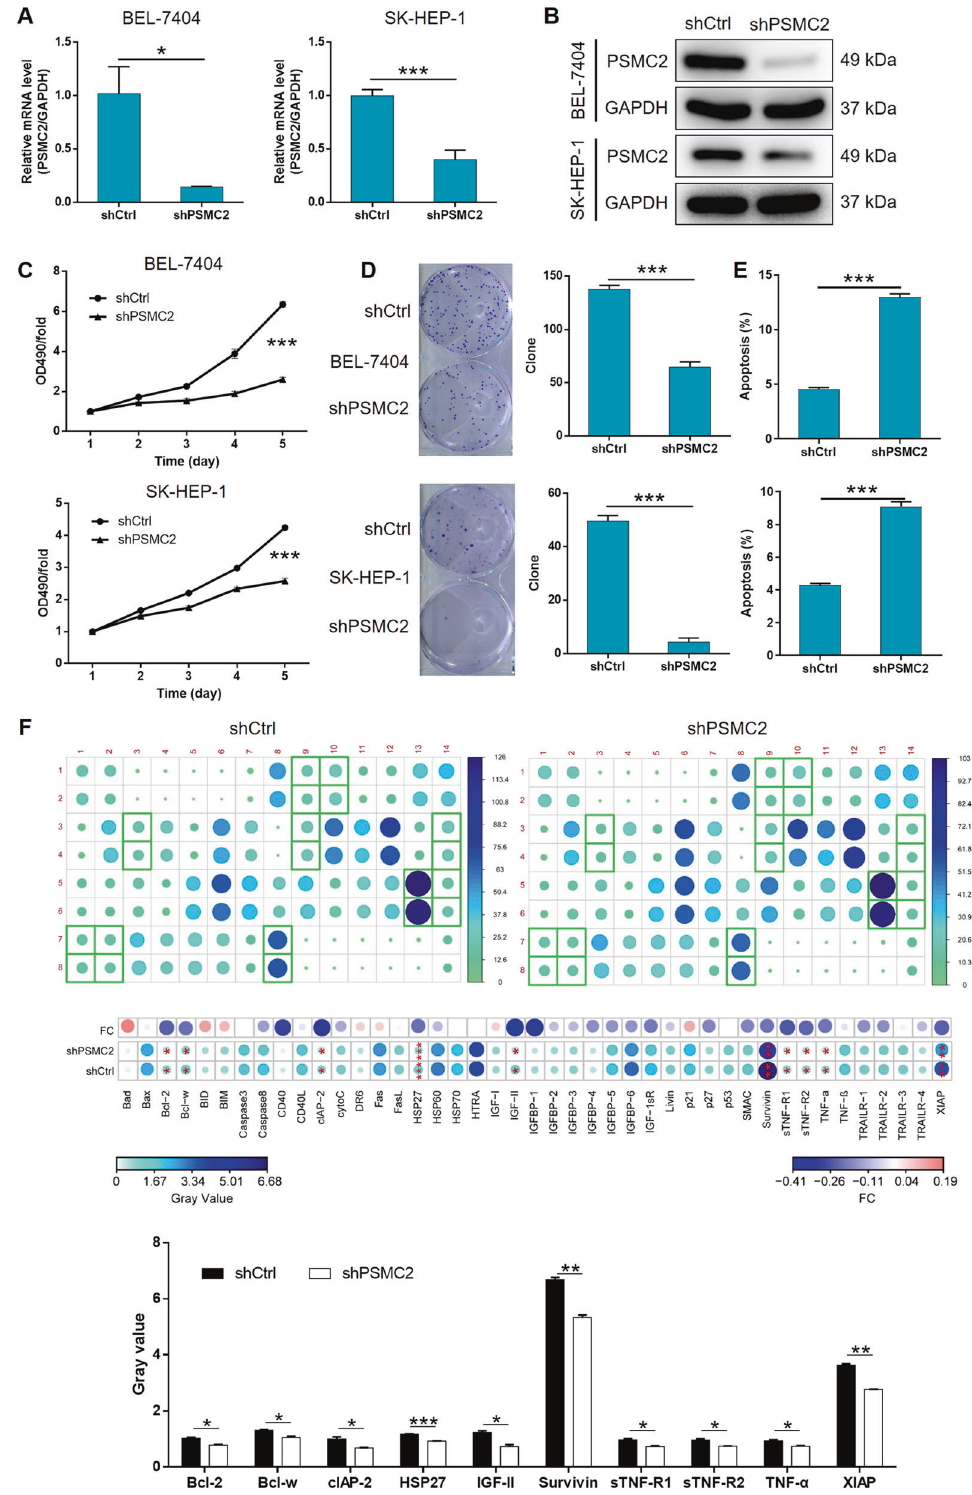
Fig. 2 PSMC2 knockdown inhibited HCC development in vitro. A , B Cells transfected with shPSMC2 or shCtrl were employed to build the cell model. The knockdown ef fi ciency of PSMC2 in BEL-7404 and SK-HEP-1 cells was estimated by qPCR ( A ) and western blotting ( B ). Herein, the GAPDH blot was shared with Supplementary Figs S2 and S5C. C MTT assay was utilized to indicate proliferation ability of BEL-7404 and SK-HEP-1 cells in fl uenced by PSMC2. D Plate clone formation assay was applied to investigate the colony formation ability of BEL-7404 and SK- HEP-1 cells with or without knocking down PSMC2. E Flow cytometry was performed to detect the effects of PSMC2 on cell apoptosis of BEL- 7404 and SK-HEP-1 cells. F The role of PSMC2 in apoptosis-related protein expression in SK-HEP-1 cells was analyzed by Human Apoptosis Antibody Array. Data were shown as mean ± SD. * P < 0.05, ** P < 0.01, *** P < 0.001.